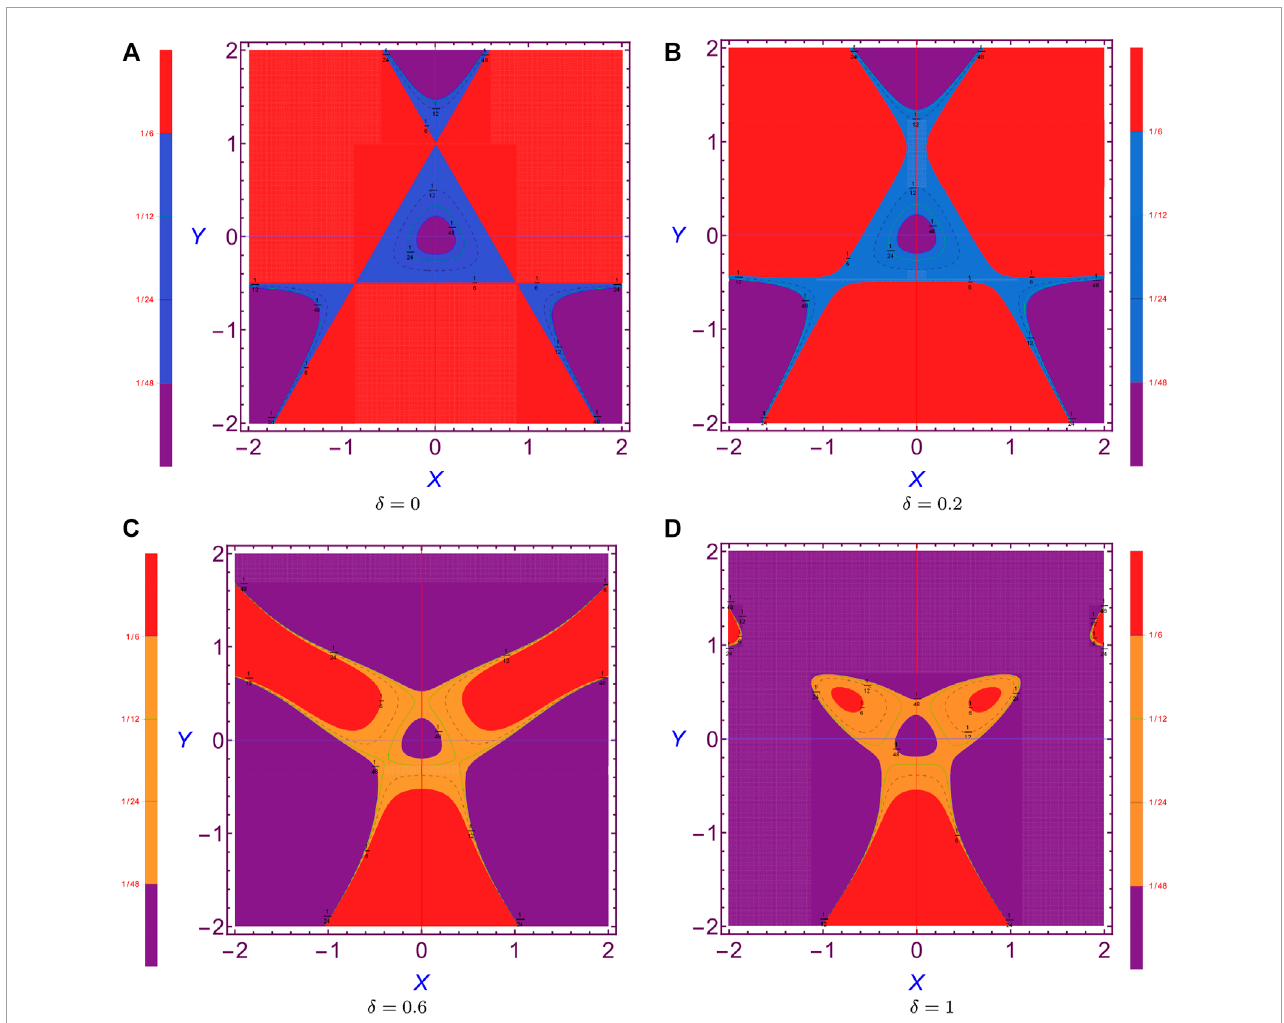
FIGURE 4 Zoomed view of Figure 1 near x , y ∈( 1 , 1 ) .